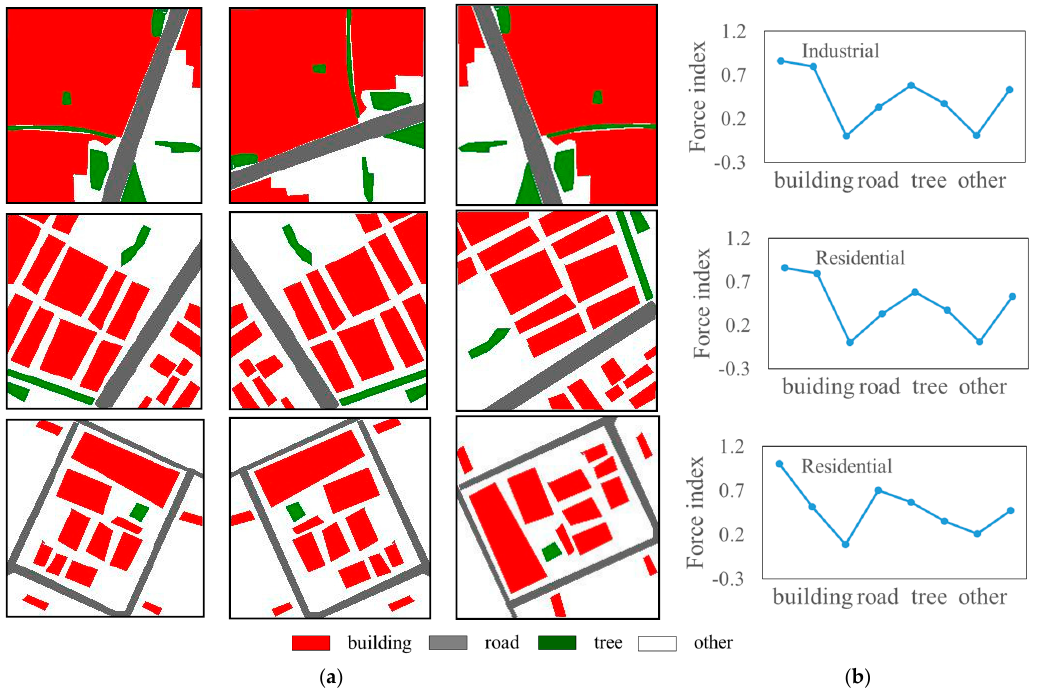
Figure 7. Visualization of the spatial layout of different scenes. ( a ) from left to right are the initial image, its rotation and its mirror. ( b ) is the MOFH. From top to bottom, the scene categories are commercial, commercial, industrial, industrial and residential, and residential.